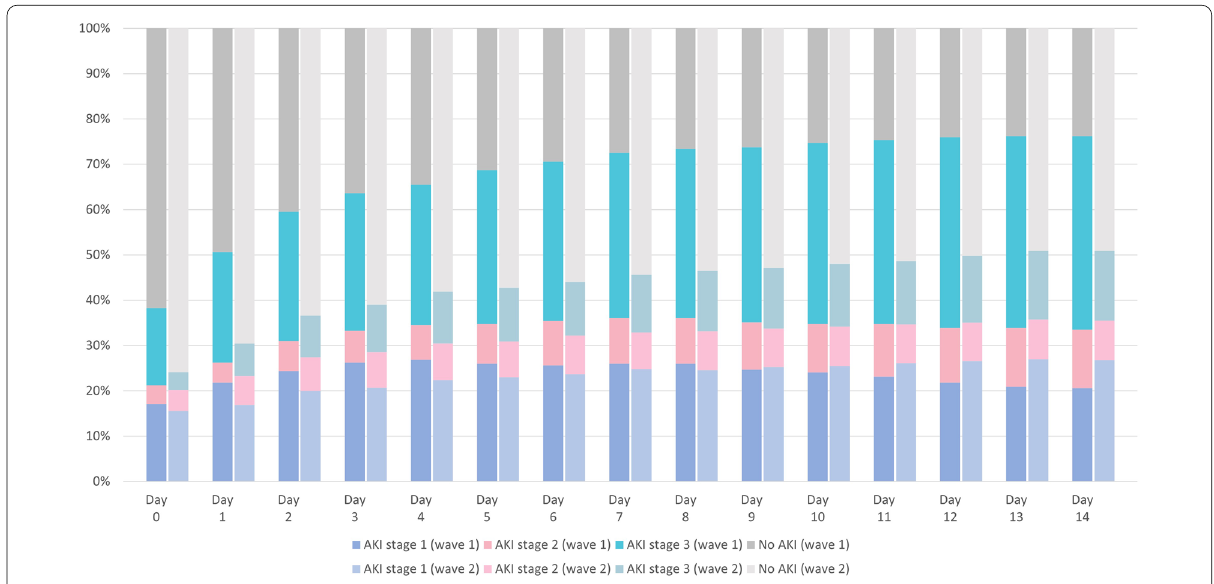
Fig. 2 AKI staging by day after ICU admission and stratified by COVID-19